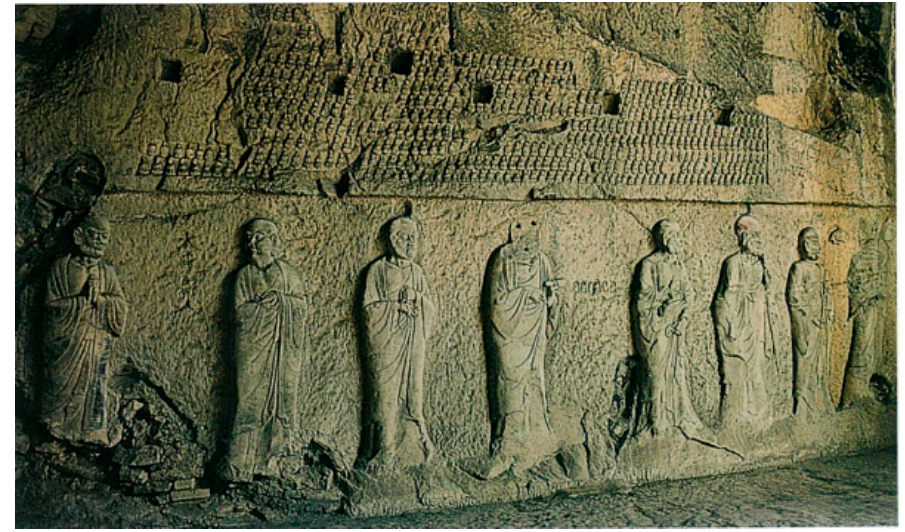
Figure 8. Patriarchal figures on the south wall of Kanjing si Cave. Longmen Grottoes, late 7th to early 8th century.